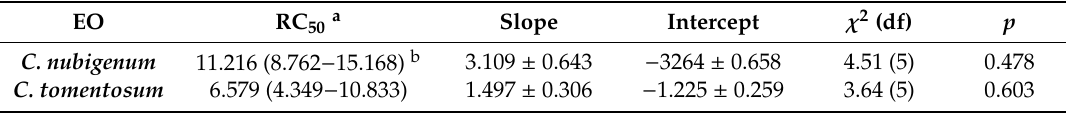
Table 2. Median repellent concentration (RC 50 ) of Clinopodium nubigenum and C. tomentosum essential oils (EOs) against Sitophilus zeamais adults. EO RC 50 a Slope Intercept